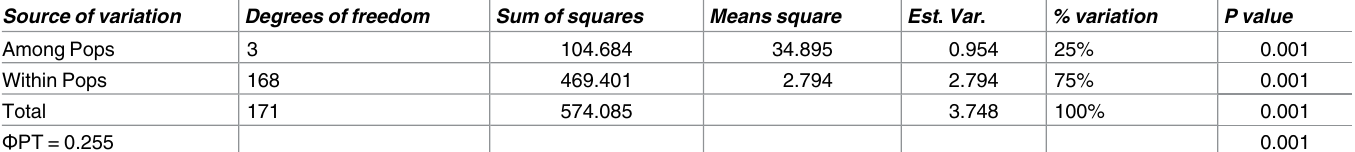
Table 1. Analysis of molecular variance(AMOVA) for 172 individuals from 4 Bgh isolate sets based on 33 polymorphisms derived from SSR, RJM, indel and SNP markers. Source of